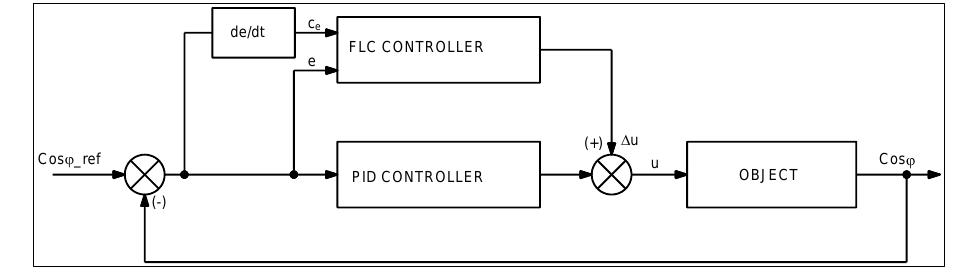
Figure 11. Hybrid PID-FLC Sugeno controller